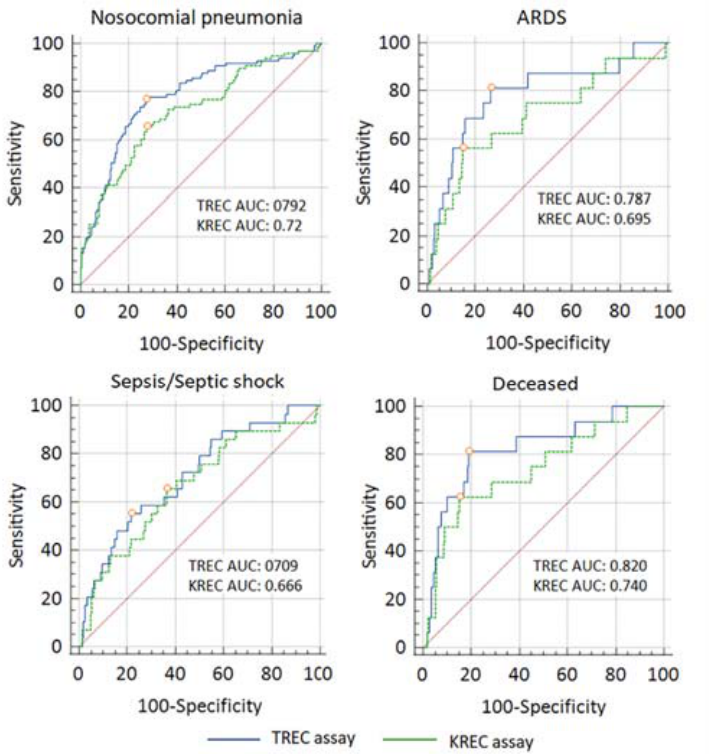
Figure 6. Receiver operating characteristic (ROC) curves for TREC/KREC levels in predicting the development, progression and outcome of pneumonia. The red dots on the ROC curves indicate the position of the optimal cut-offs determined by Yudin’s J-statistics. The red diagonal line denotes the ROC curve of a random classifier. Other summary statistics on the results of the ROC analyses are presented in Supplementary Table S4.